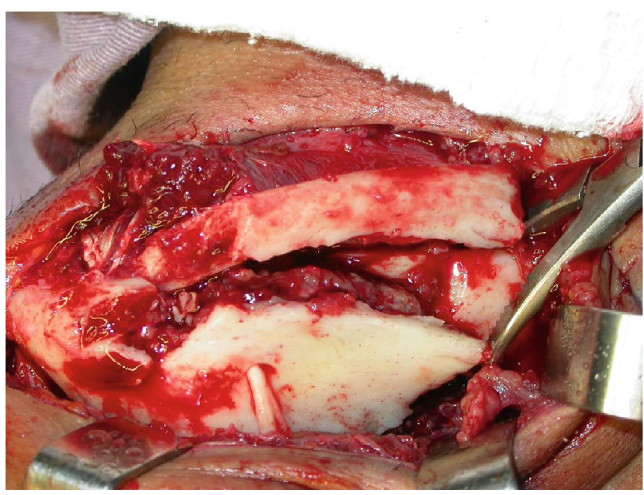
Figure 7: Exposure of complex mandible fracture.